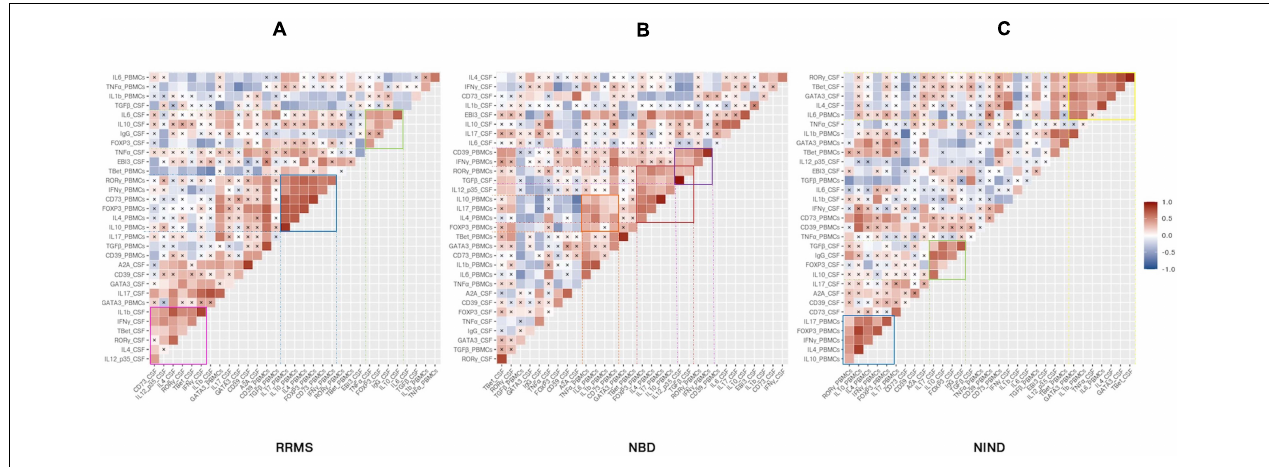
FIGURE 5 | Specific CSF and blood genes co-regulation implicated in physiopathology of inflammatory and non-inflammatory diseases. The heatmap illustrates Pearson’s correlation between gene variables expressed in RRMS (A) , NBD (B) , and NIND (C) disease. Genes were ordered based on hierarchical clustering. The color intensity is proportional to the magnitude of the correlation coefficient. Positive correlations are displayed in red, negative correlations are colored in blue. Crosses indicate a non-significant correlation ( p <